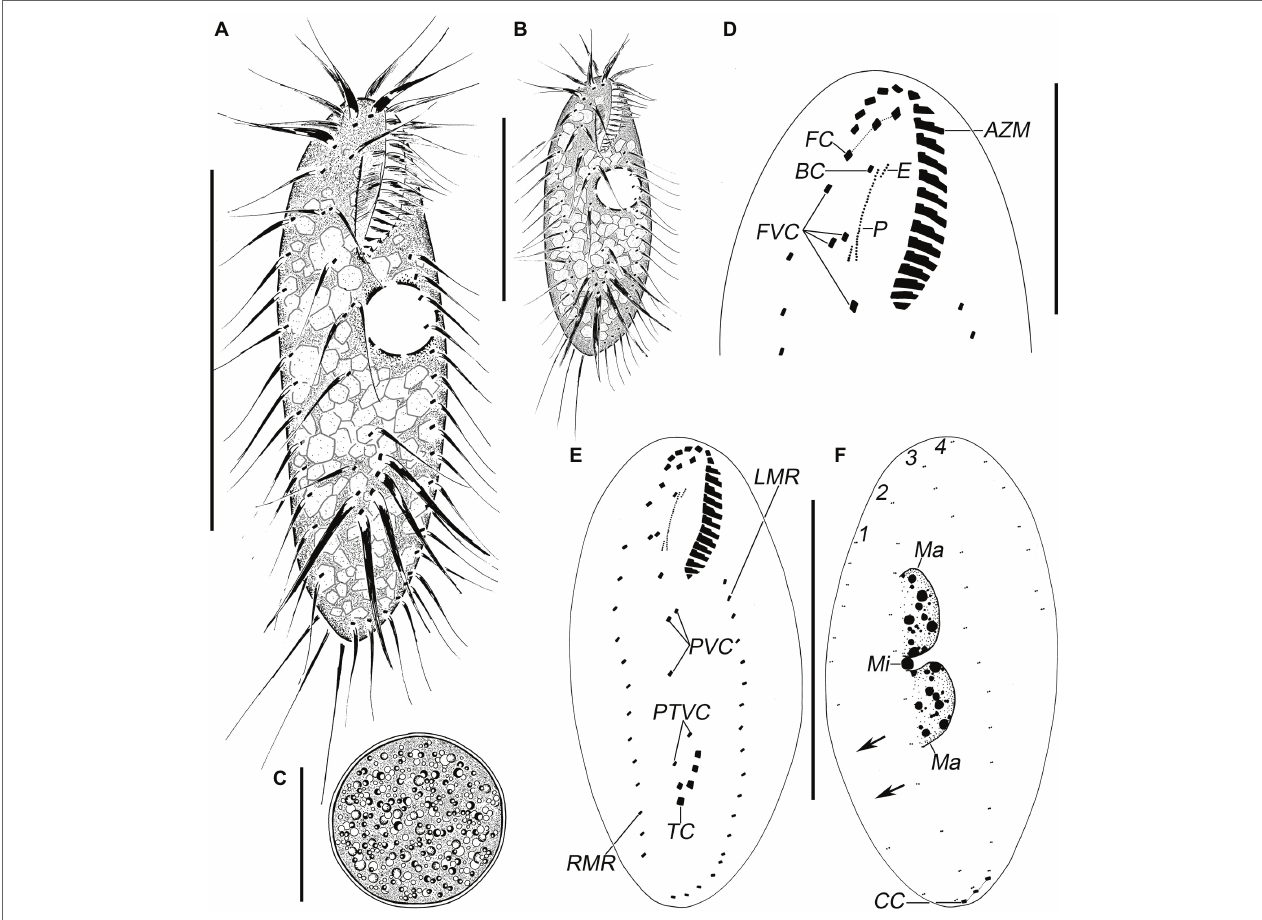
FIGURE 1 | Quadristicha subtropica n. sp., morphology from life (A–C) and after protargol staining (D–F) . (A,B) Ventral views, to show different body shapes. (C) Resting cyst. (D) Detailed ventral view of the anterior region. (E,F) Ventral (E) and dorsal (F) view of the holotype specimen to demonstrate the infraciliature; arrows mark the gap in dorsal kinety 1. 1–4, dorsal kineties 1–4. Bars: 50 μ m (A,B) ; 30 μ m (C,D) ; 70 μ m (E,F)